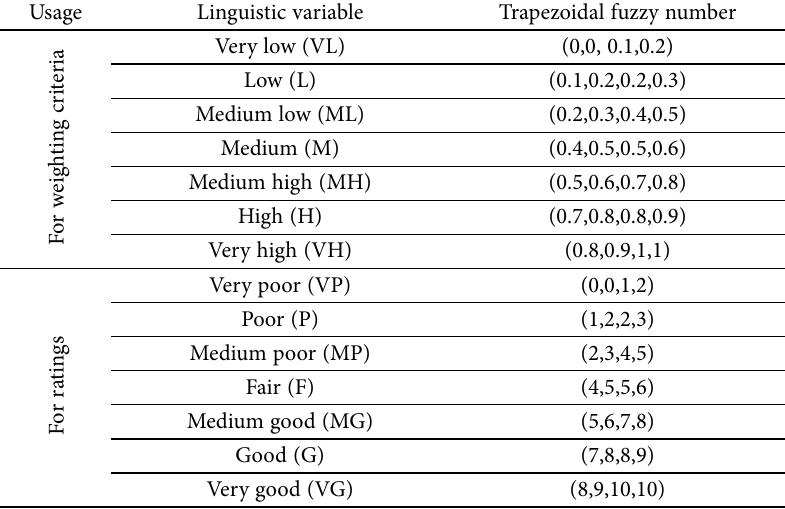
Table 3. Linguistic variables with fuzzy